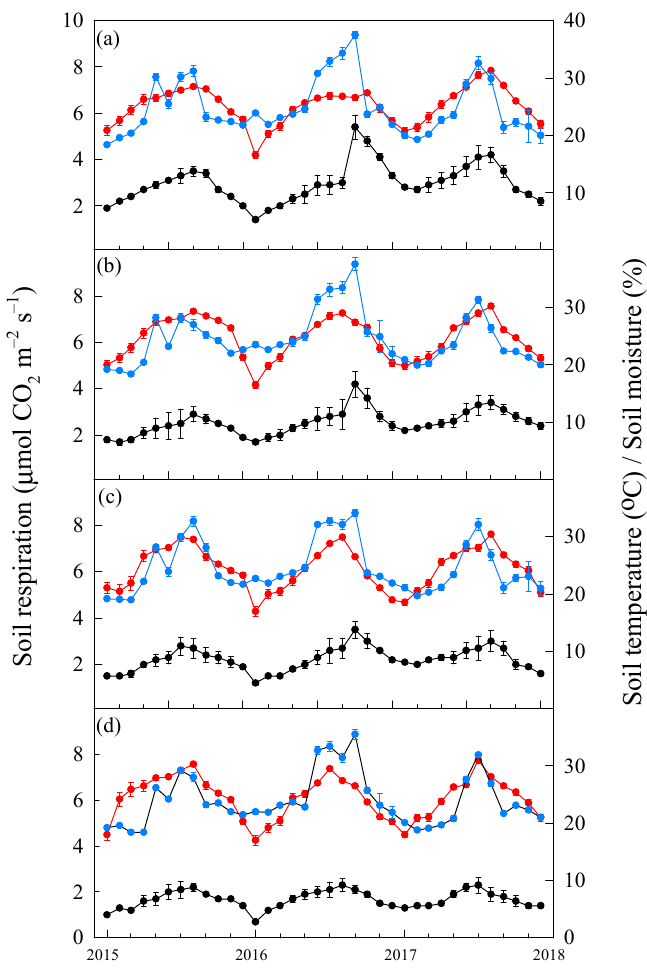
Figure 3. Monthly variations in soil respiration ( µ mol m − 2 s − 1 ), soil temperature ( ◦ C) and soil moisture from 2015 to 2017 for the different tree species: ( a ) mahogany, ( b ) Indian almond, ( c ) rose wood, and ( d ) China berry. The black, red, and blue solid circles represent the soil respiration, soil temperature, and soil moisture, respectively; error bars represent standard deviations ( n = 4). Table 1. Interannual variations in Rs from 2015 to 2017 for the different tree species: mahogany, Indian almond, rose wood, and China berry. Different capital letters indicate differences among years for the same species at p < 0.05. Different lowercase letters indicate differences among species within the same years at p < 0.05. Values indicate means ± standard deviations ( n = 4).